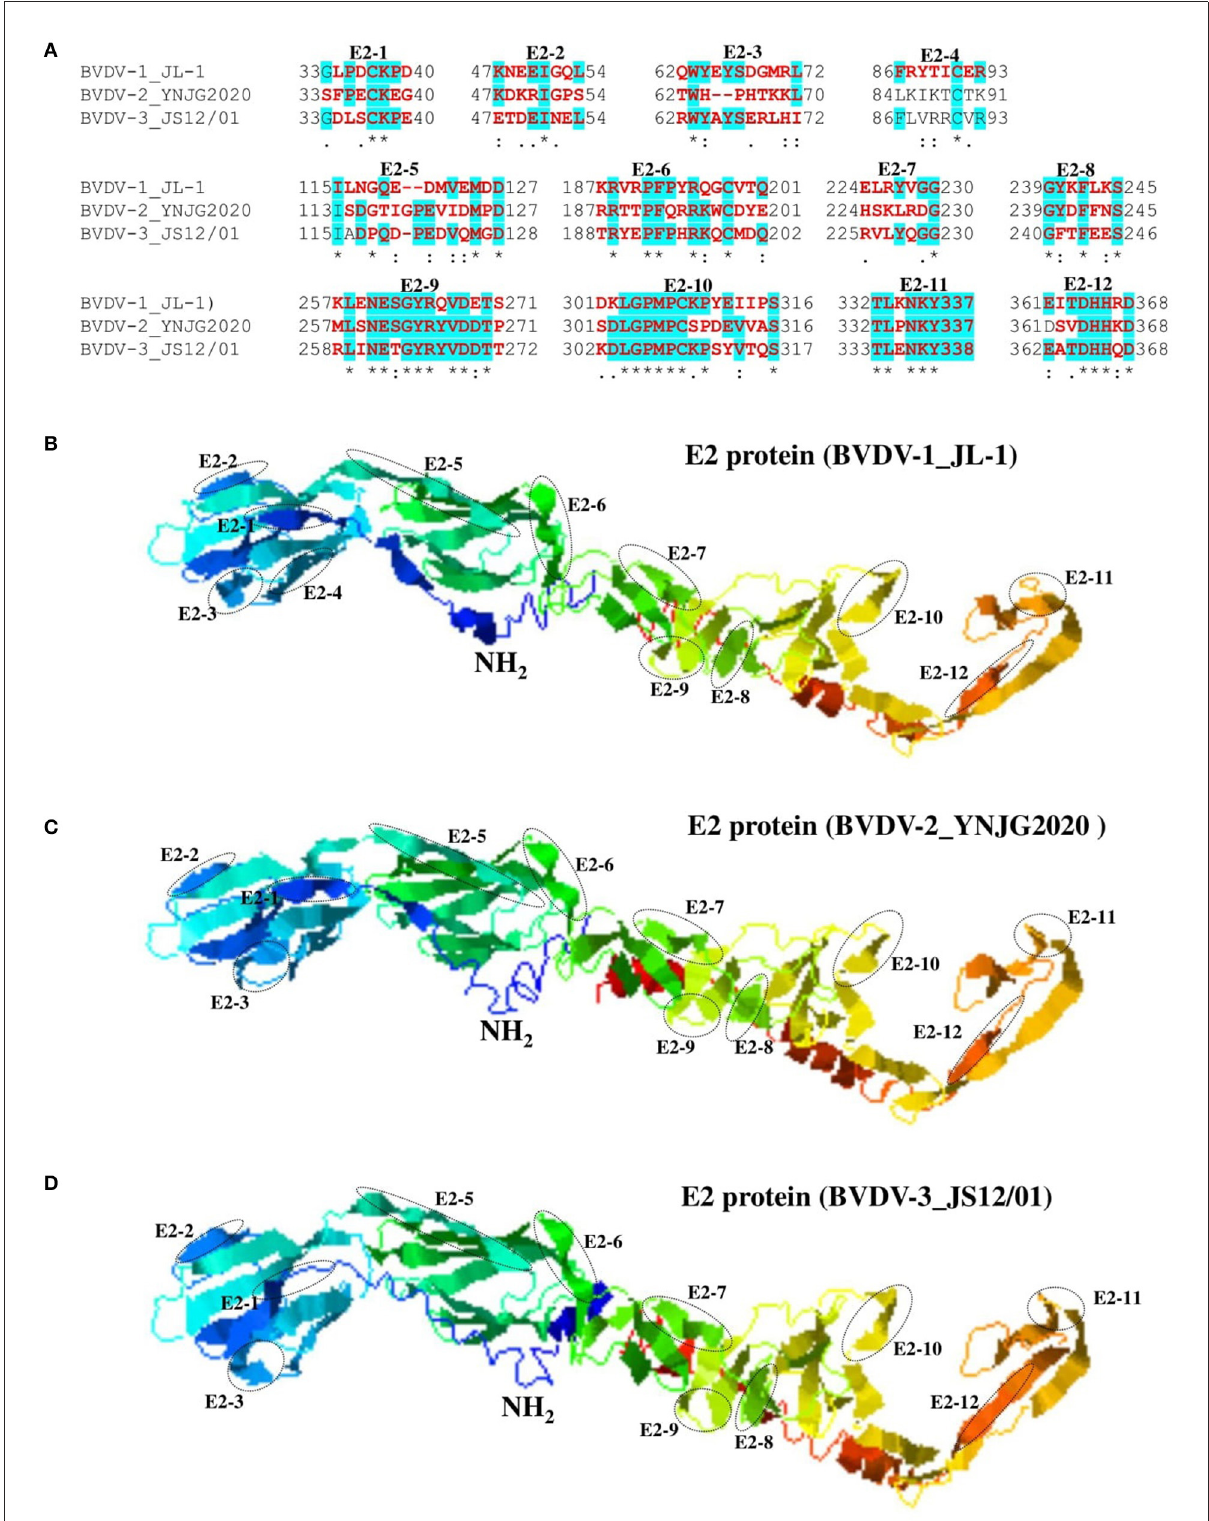
FIGURE6 Comparison of linear B cell epitopes affected by amino acid variations in the E2 protein. (A) Amino acids of the predicted linear B cell epitope are indicated with bold red letters, while numbers refer to their positions relative to the full-length E2 protein (Protein ID = AII17592.1). (B) Three-dimensional view of epitopes in the E2 domain of BVDV-1_JL-1. (C) Three-dimensional view of epitopes in the E2 domain of BVDV-2_YNJG2020. (D) Three-dimensional view of epitopes in the E2 domain of BVDV-3_JS12/01. The predicted epitopes are circled and